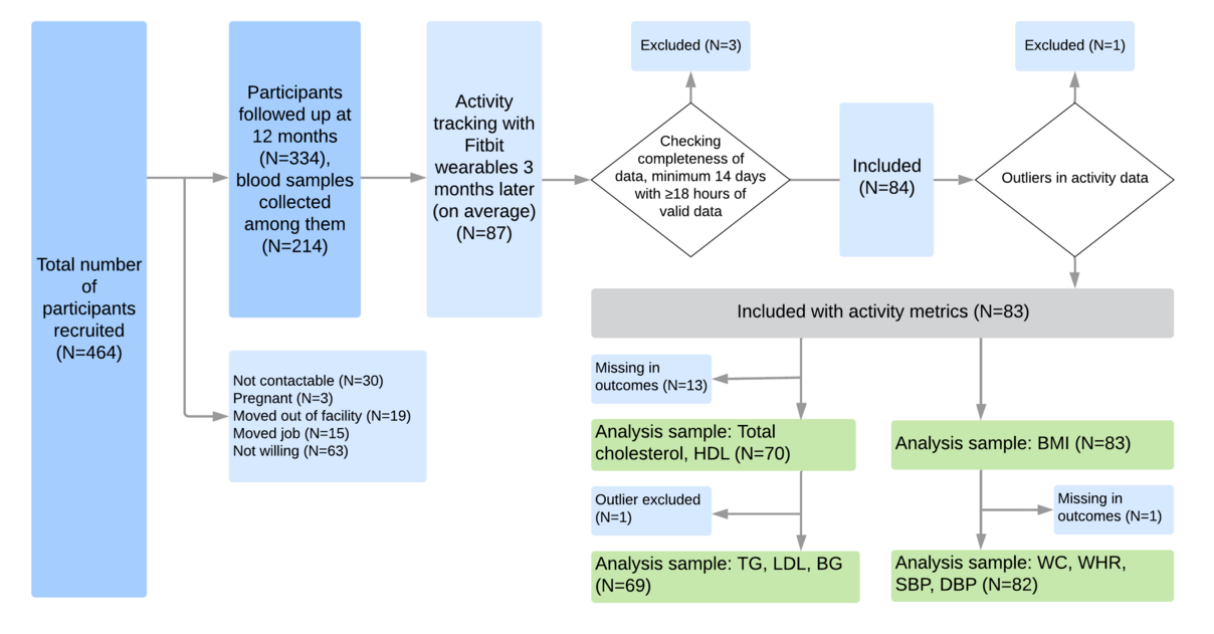
Figure 2. Participants flow diagram. BG: blood glucose; DBP: diastolic blood pressure; HDL: high-density lipoprotein; LDL: low-density lipoprotein;